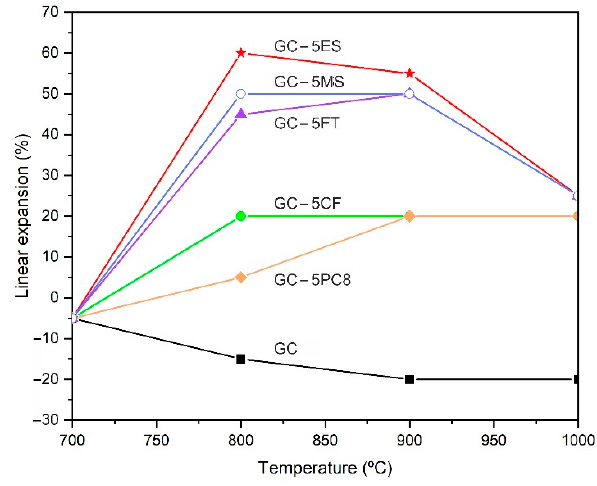
Figure 4. Evolution of linear expansion (LE) with temperature in pressed pellets formulated with different additives (5 wt. %) and foamed for 15 min (base glass particle size < 1 mm). The difference in behavior observed in the expansion capacity of the different wastes used as additives is related to the starting temperature of carbonate decomposition [39,44].